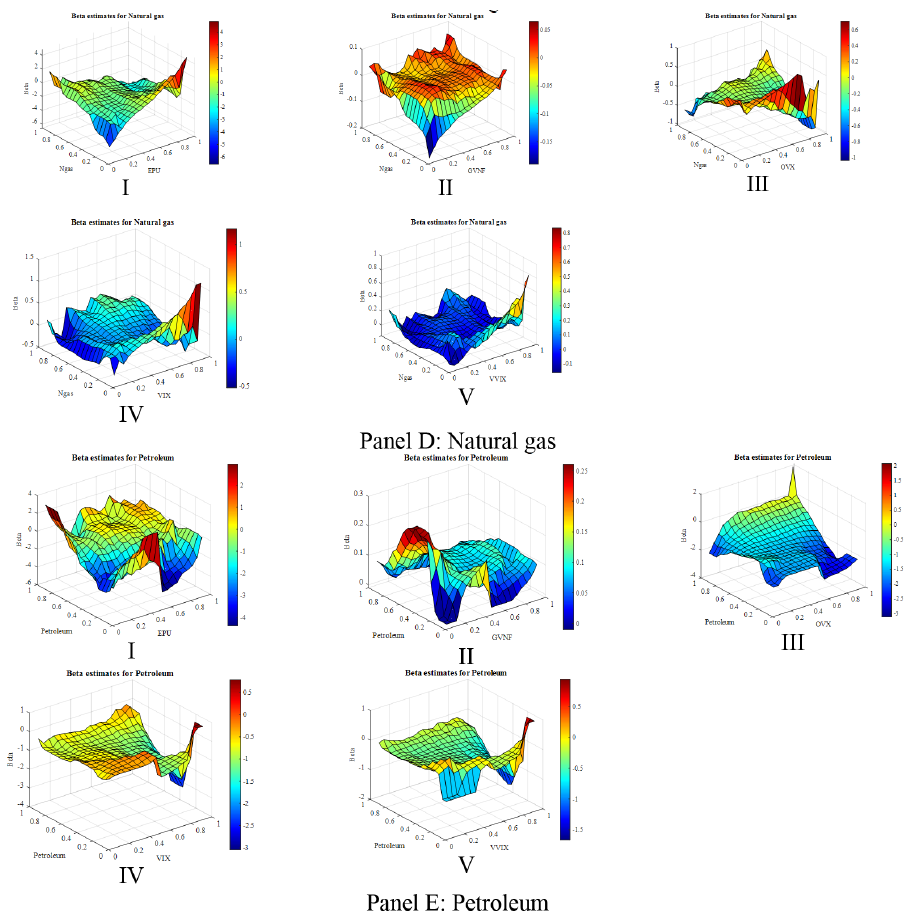
Figure 3. 3D analysis of QQR